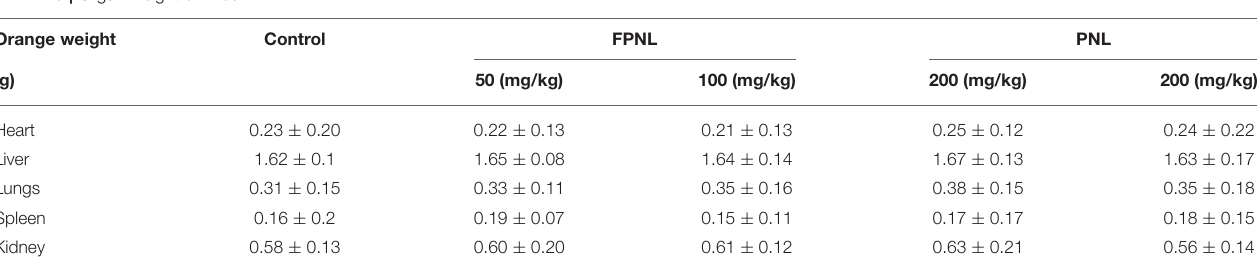
TABLE 3 | Organ weight of